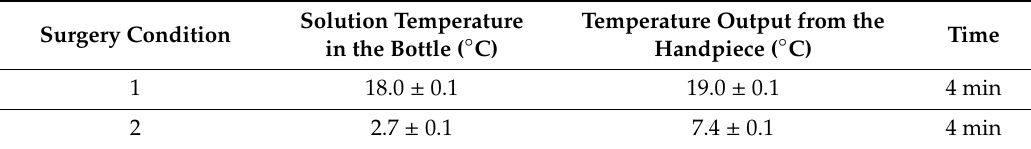
Table 3. The temperature of the saline solution detected at the outlet of the phacoemulsifier handpiece in the absence of ultrasound (US), under conditions 1 and 2.